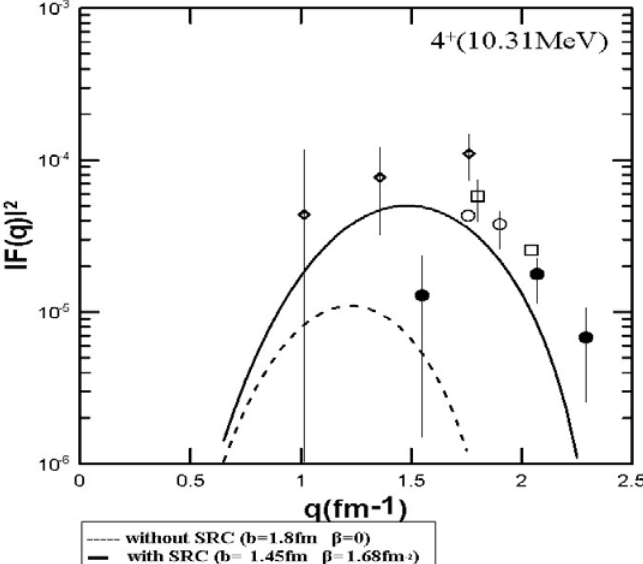
Fig. 8: Inelastic Coulomb 4 C form factors for the transition to the 14 + (10.31 MeV) state. The dashed and solid curves are the calculated 4 C form factors without and with the inclusion of the effect of the SRC, respectively. The open circle, closed circle, open square and rhombic symbols are those of the experimental data taken from